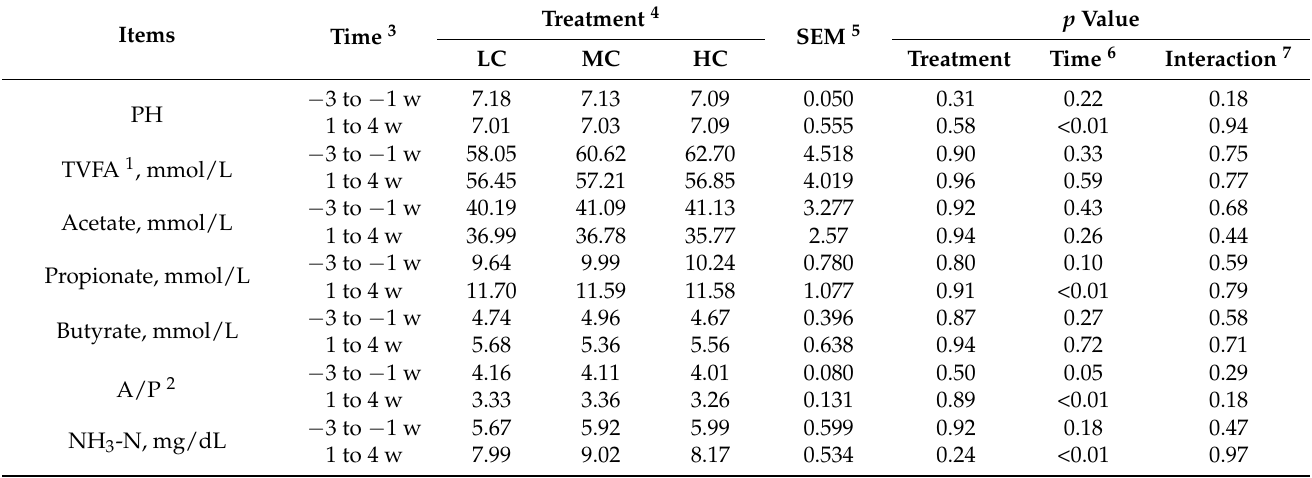
Table 7. Effects of different prenatal concentrate levels on the rumen fermentation parameters of prepartum and postpartum dairy